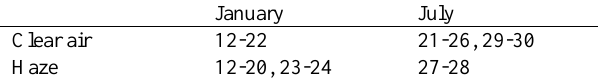
Fig. 1. Data from July 24–25 are missing due to adverse weather factors. In winter, the daily mean AOD was 0.34 under clear air and was 0.79 in haze event. It fluctuated drastically from maximum 1.55 (January 13) to minimum 0.29 (January 21) during whole study periods and the AE changed from 0.84 to 1.74. Before January 20, the mean AOD was 0.94 showing relatively heavy haze. After this, AOD decreased and reached about 0.37 showing the influence on coarse mode particles. While, the daily mean AOD changed from 0.64 under clear air to 1.36 during haze event in summer. The mean daily AE almost unchanged around 1.40 showing dominant fine mode particle. In general, compared with the haze in winter, the mean AOD and AE were both larger during summer haze periods.